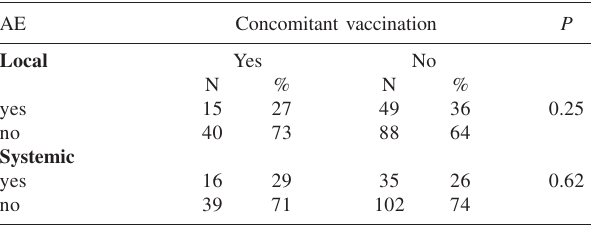
AE – adverse events; HCW – Health Care Workers; n-number; %- percentage Table 5 - Occurrence of local and systemic adverse events after influenza vaccination according to concomitant administration of other vaccines. Hospital das Clínicas, São Paulo University Medical School.